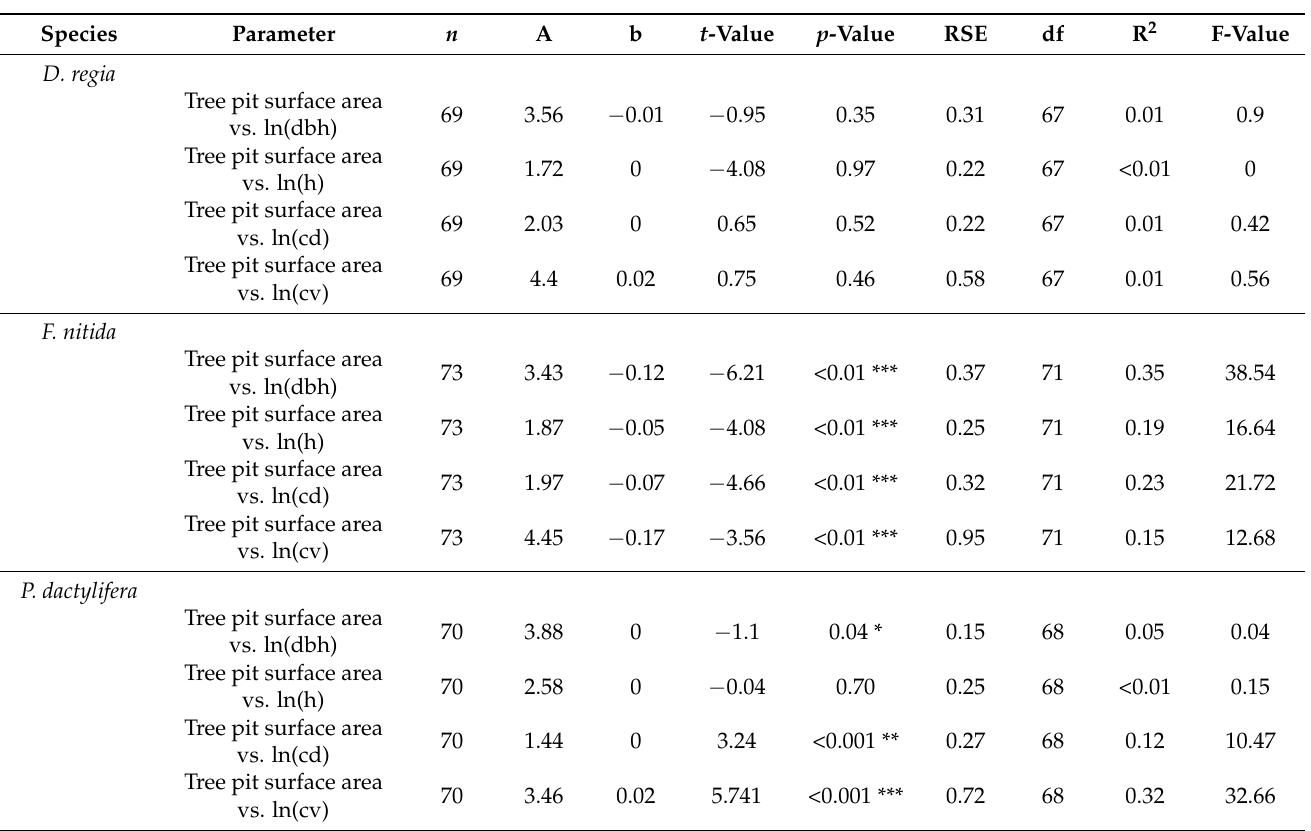
Table 5. Results of the summary of the regression analysis of tree pit surface area, the predictor variables, and diameter at breast height (dbh), tree height (h), crown diameter (cd), and crown volume (cv), as a response, and the regression equation ( y ) = a + b × ln ( x ) . The table below lists the determination of R 2 , residual standard error, and p -values. The R 2 value and the p -value (with levels of significance indicated by symbols such as ***, ** and *)for each ANOVA show the relationship between the tree structural variables and the tree pit surface area for the